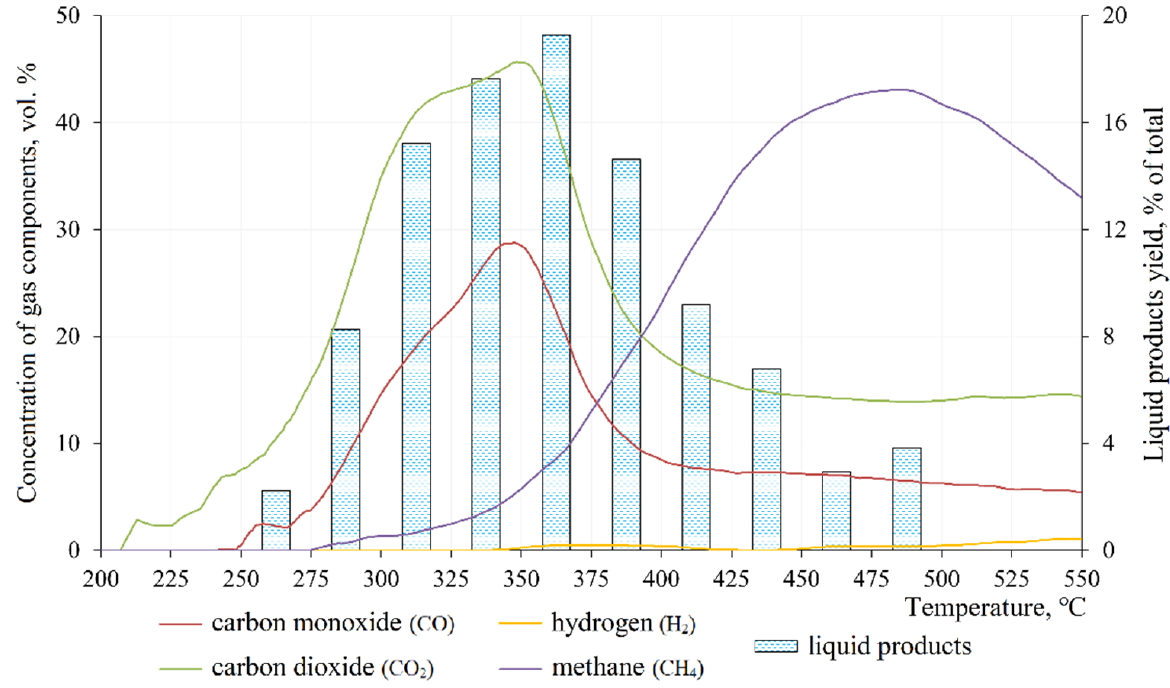
Figure 9. Pyrolysis gas composition and yields of liquid products in processing the Siberian pine nutshell.